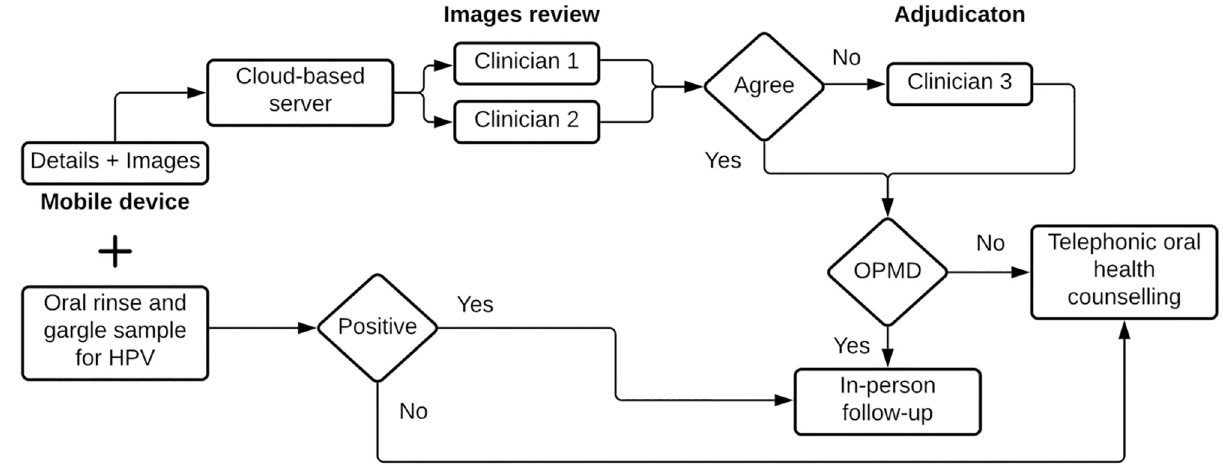
Fig 1. Scheme of study